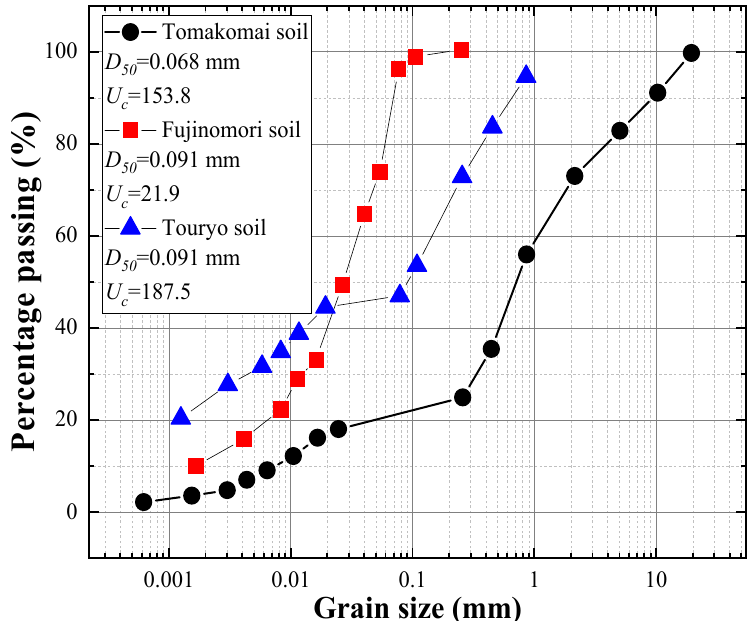
Figure 3. Grain size distribution curve of simulated soil samples.